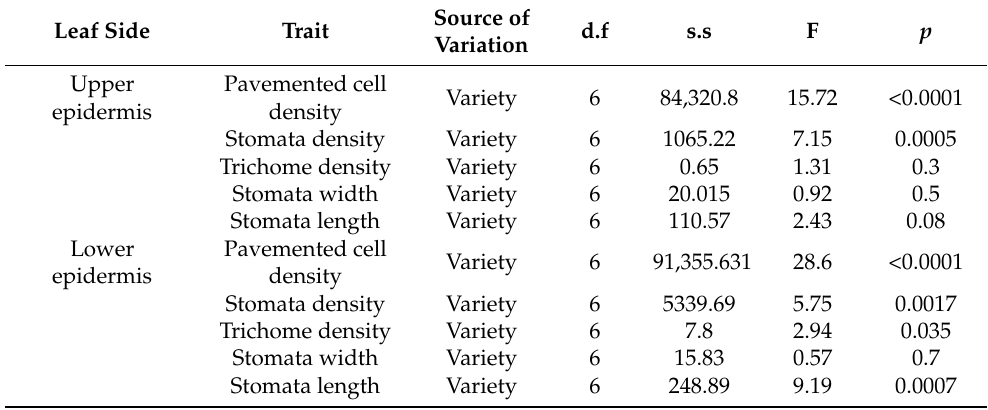
Table 2. Univariate ANOVA to compare the density and size of the upper and lower epidermis of the wild Capsicum annuum var. glabriusculum and six Mexican cultivated varieties. Trait Source of Variation d.f